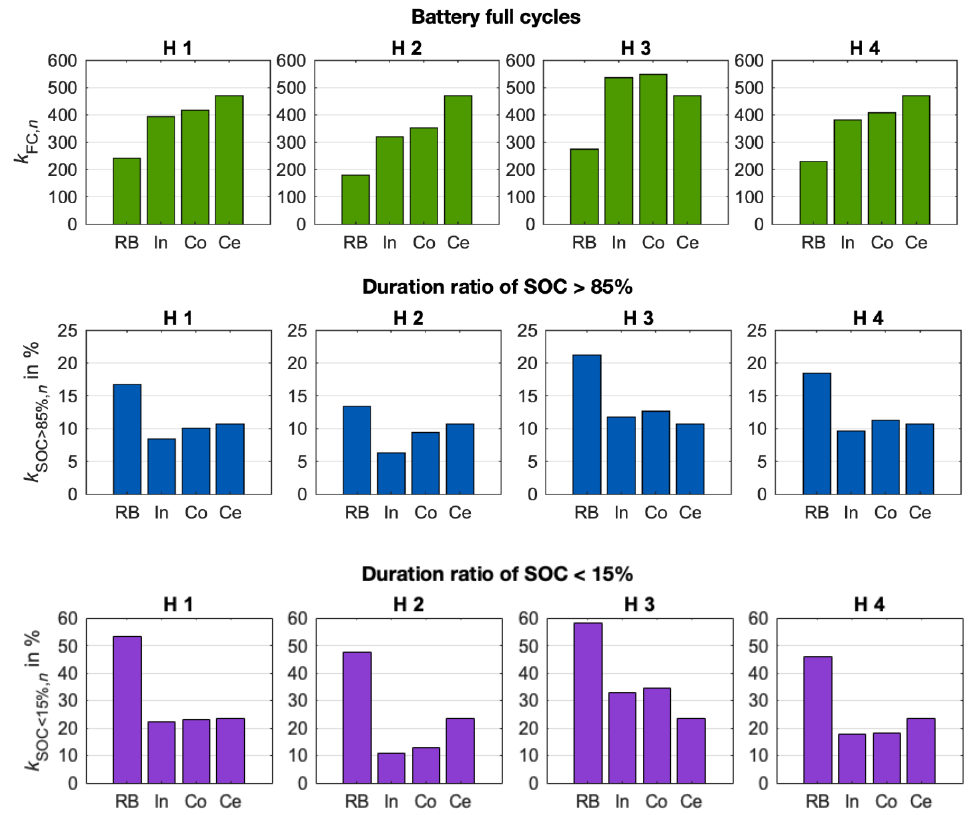
Figure 14. Battery stress criteria for the investigated EM concepts (In: IndOpt, Co: CoordOpt, Ce: CentralOpt, H: household).